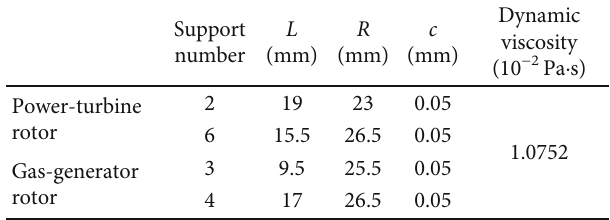
Table 4: Parameters of SFDs.